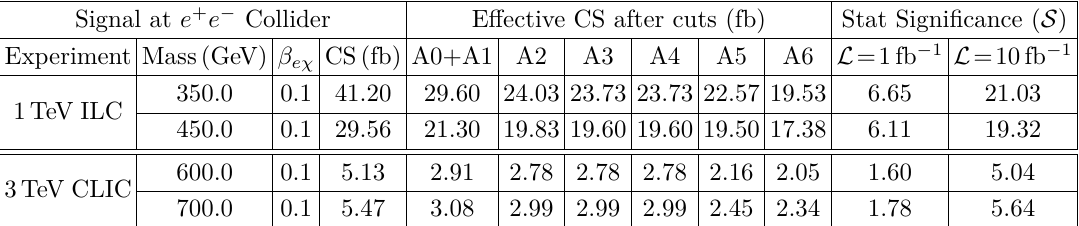
√ s = 1 TeV) and CLIC (